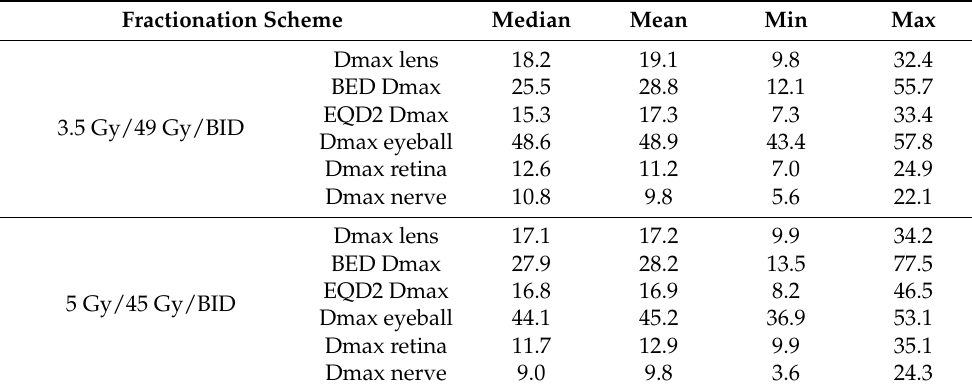
Table 3. Characteristics of doses achieved in critical